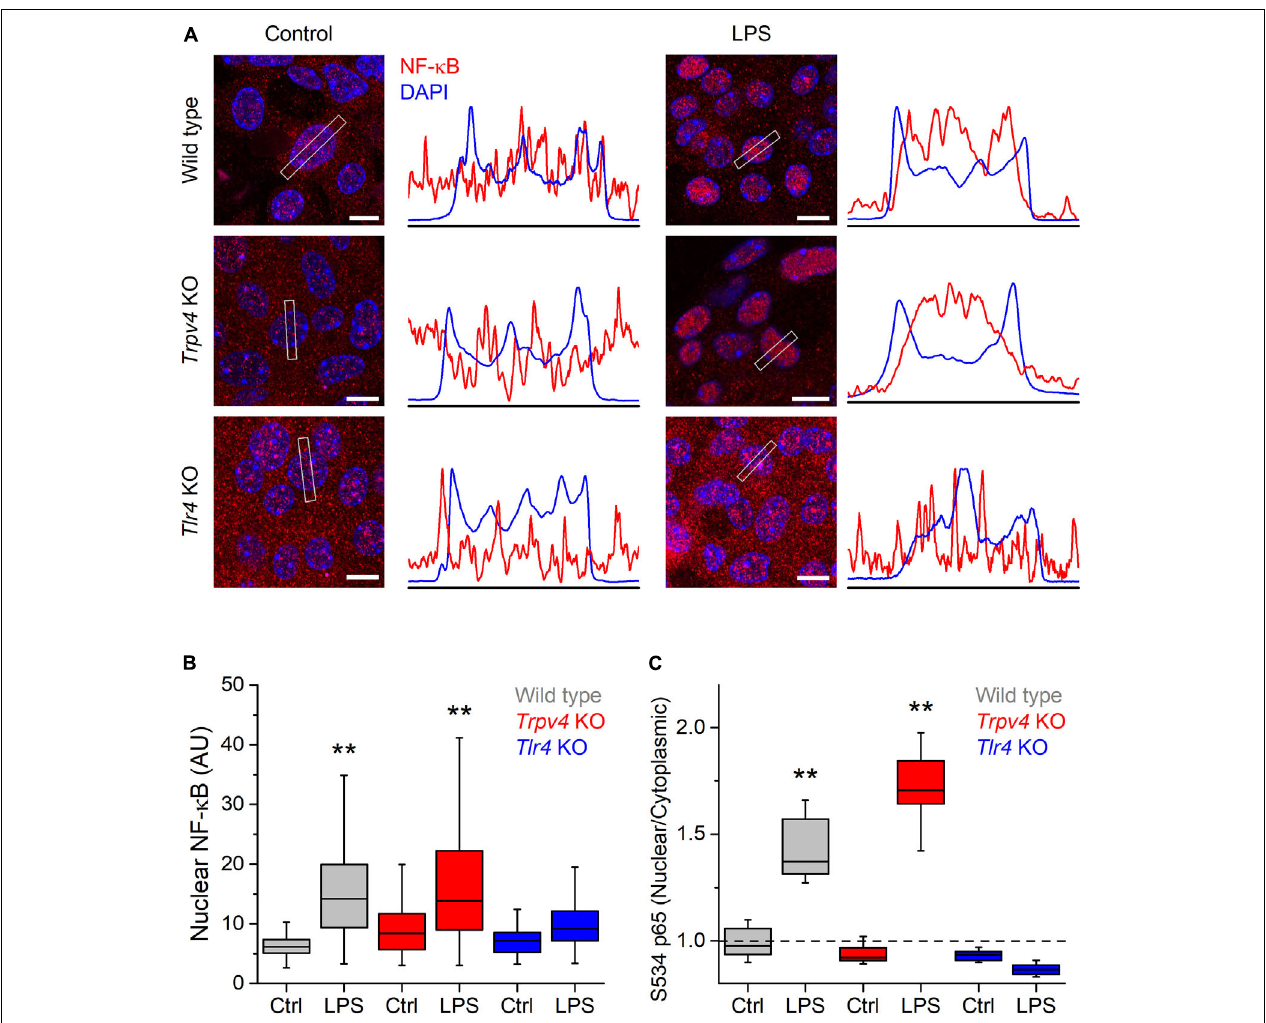
FIGURE 5 | TRPV4 is not required for the phosphorylation and nuclear translocation of NF- κ B induced by E. coli LPS in mouse urothelial cells. (A) Representative confocal immunofluorescence microscopy images of fixed mUCs in control or 30 min after treatment with LPS (20 µ g/ml). Cells were stained with NF- κ B p65 (red) and DAPI nuclear staining (blue). Scale bar, 10 µ m. The average linear intensity along the gray rectangle is represented next to each image. (B) Mean intensity of nuclear NF- κ B p65 staining in mUCs in control or 30 min after treatment with LPS (20 µ g/ml, 30 min). The data is represented in a box plot indicating the median (black line), the 25–75 percentiles (box) and the 10–90 percentile range (whiskers). The ** symbols indicate P < 0.01 and with a Tukey’s multiple comparison test (the n values (control/LPS) are 53/100 for WT, 96/92 for Trpv4 KO and 88/103 for Tlr4 KO). (C) Average nuclear/cytoplasmic ratio of S534 p65 subunit in mUCs in control or 30 min after treatment with LPS (20 µ g/ml, 30 min). The data is represented in a box plot indicating the median (black line), the 25–75 percentiles (box) and the 10–90 percentile range (whiskers). The ** symbols indicate P < 0.01, with a Tukey’s multiple comparison test. At least eight randomly selected images were analyzed per conditions from three independent